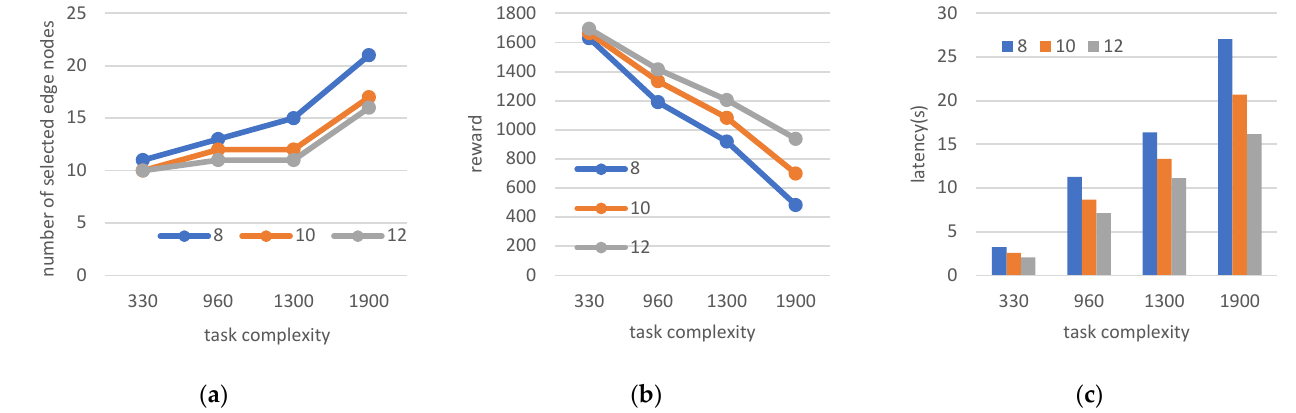
Figure 10. ( a ) Number of selected edge nodes; ( b ) reward; ( c ) latency when changing the task complexity and edge node processing capability.